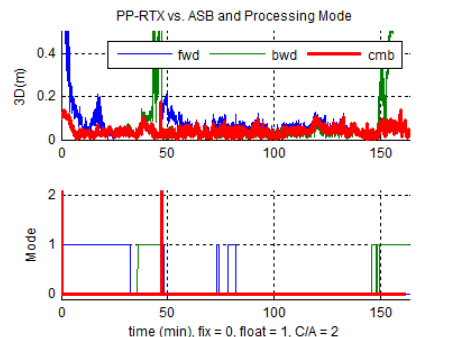
Figure 13: Forward, Backward & Combined PP-RTX vs. ASB and Processing Mode (with short